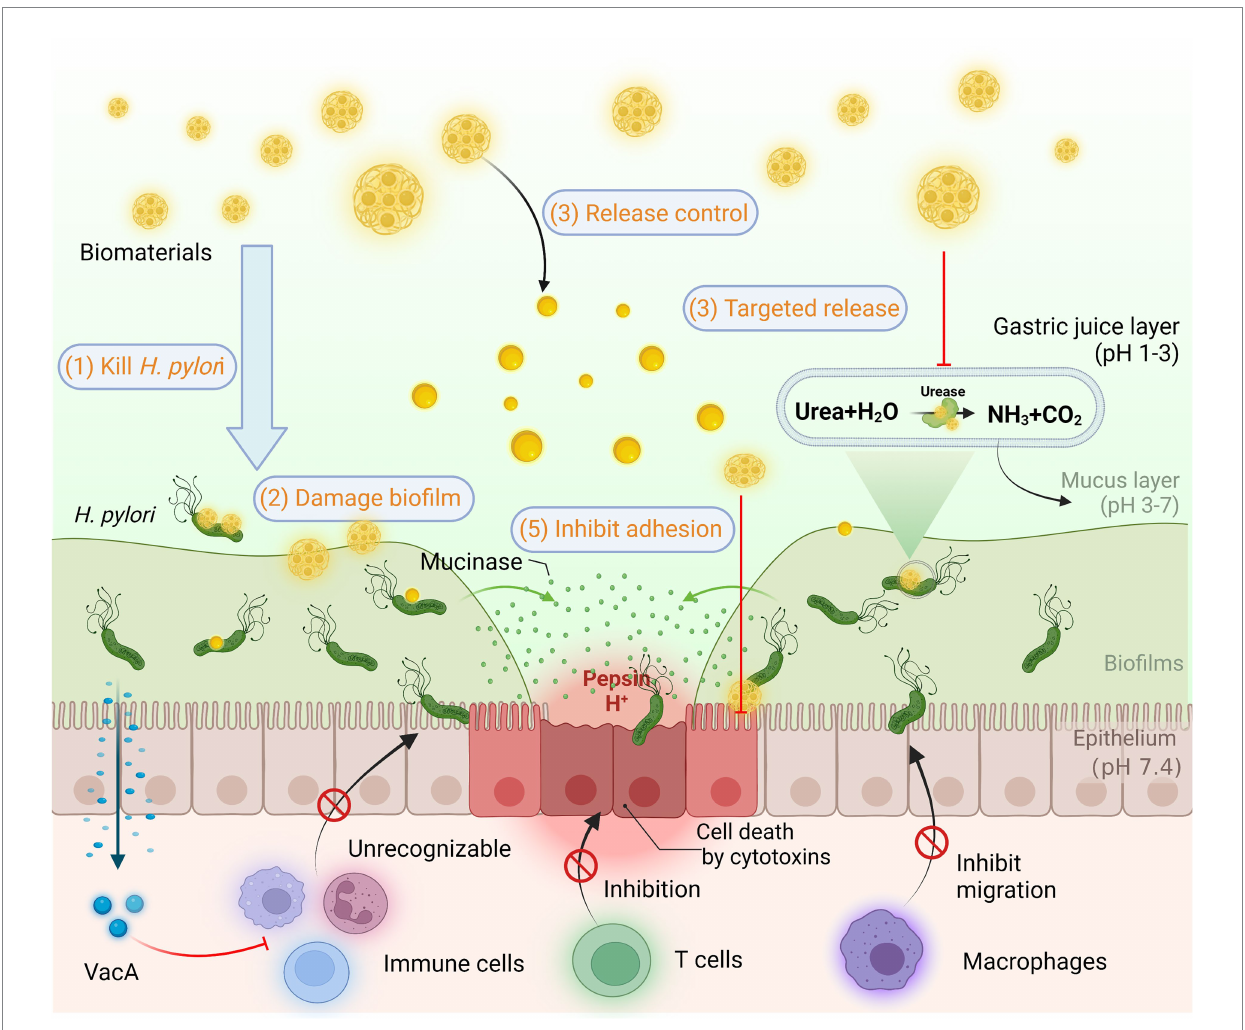
FIGURE 7 Helicobacter pylori infection and common methods of biomaterials in Anti- H. pylori . H. pylori colonizes and survives for a long time in the body through resistance to acidic environment, biofilm formation, and immune escape. Biomaterials are designed for H. pylori eradication by killing H. pylori , destroying biofilms, releasing controlled drugs, targeting drug delivery, inhibiting adhesion, and enhancing immunity based on superior